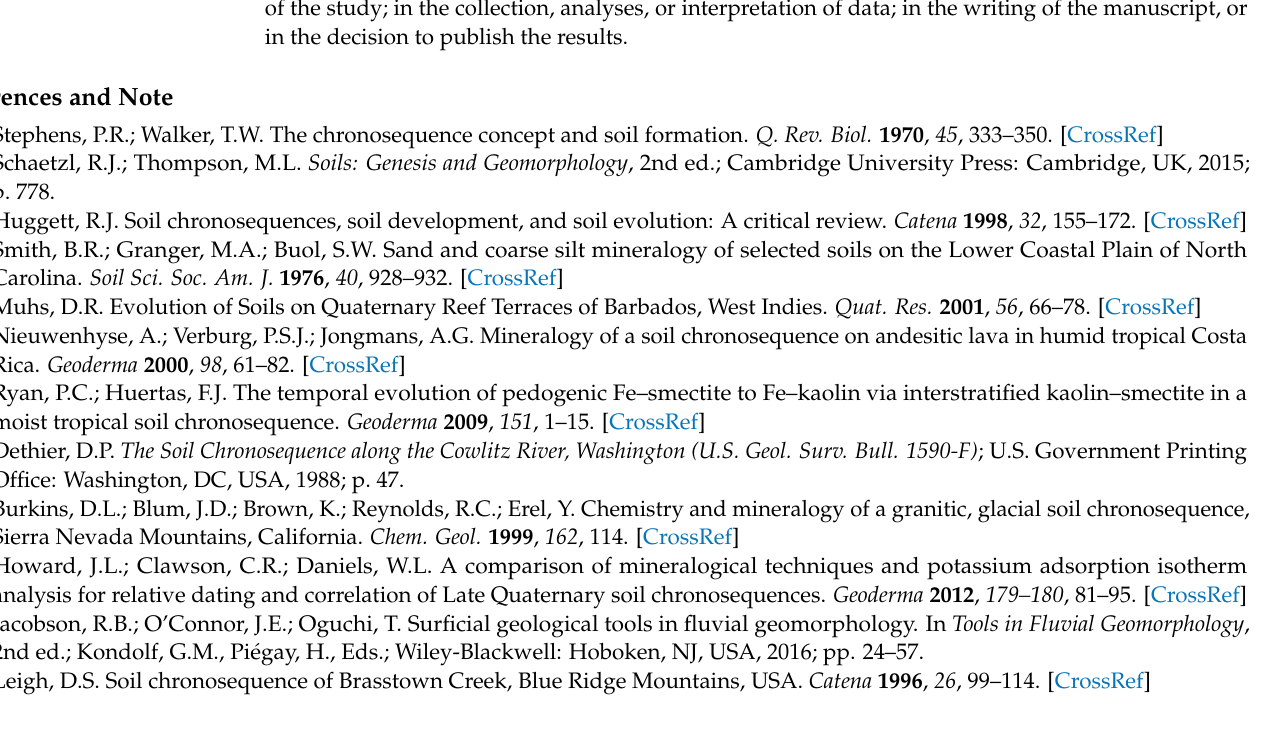
Table S3: Fe chemistry of subsoil horizons, Table S4: Statistics for regressions of <2 mm fraction chemical properties against mean age, Table S5: Statistics for regressions of 0.125–0.250 mm fraction chemical properties against mean age, Table S6: Statistics for regressions of <2 mm fraction K 2 O concentrations against mean